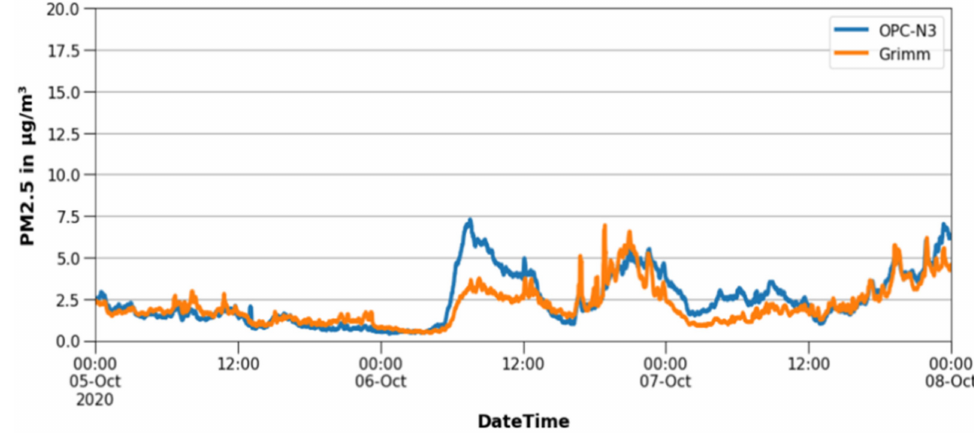
Figure 18. Average minute values for PM2.5 comparison from the two OPCs. The atmospheric sensors were compared with the Compact Weather Station MaxiMet GILL. The parallel measurements were carried out over a period of four days. Figure 19 a–c shows the comparison of the air temperature, air pressure, and relative humidity data respectively obtained with the two devices. The results obtained showed good agreement between the sensor and the reference device. Therefore, no correction was applied to the temperature and pressure raw data from the iMet-XQ2. The average relative humidity values measured by the two atmospheric sensors showed a similar trend. However, there was an offset between the two devices which was corrected during the evaluation.